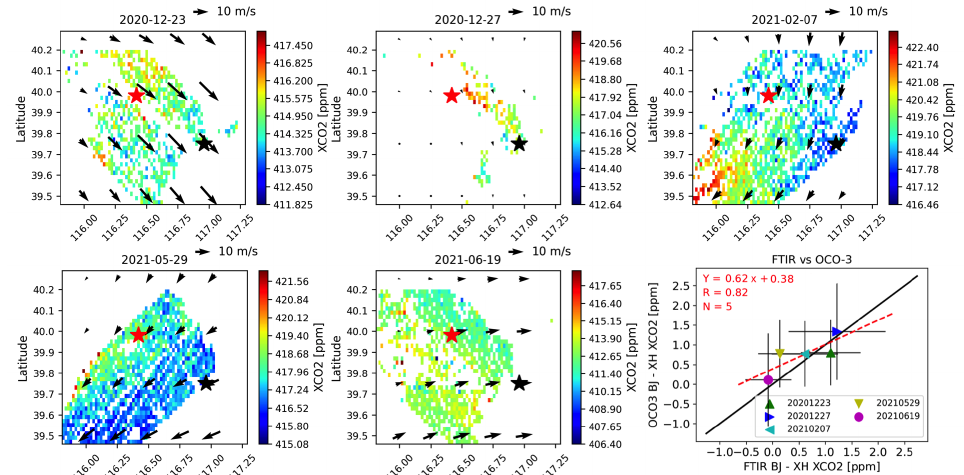
Figure 9. The spatial distribution of XCO 2 observed by the OCO-3 SAM measurements, together 2021, and 19 June 2021 over Beijing and Xianghe FTIR sites, remarked as the red and black stars, respectively. The right bottom panel is the scatter plot between the ∆ XCO 2 (BJ-XH) observed by FTIR measurements and ∆ XCO 2 observed by the OCO-3 SAM measurements. The error bar is the uncertainty of the FTIR and OCO-3